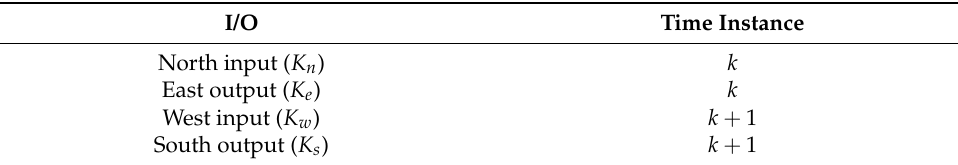
Table 1. I/Os timing for block k